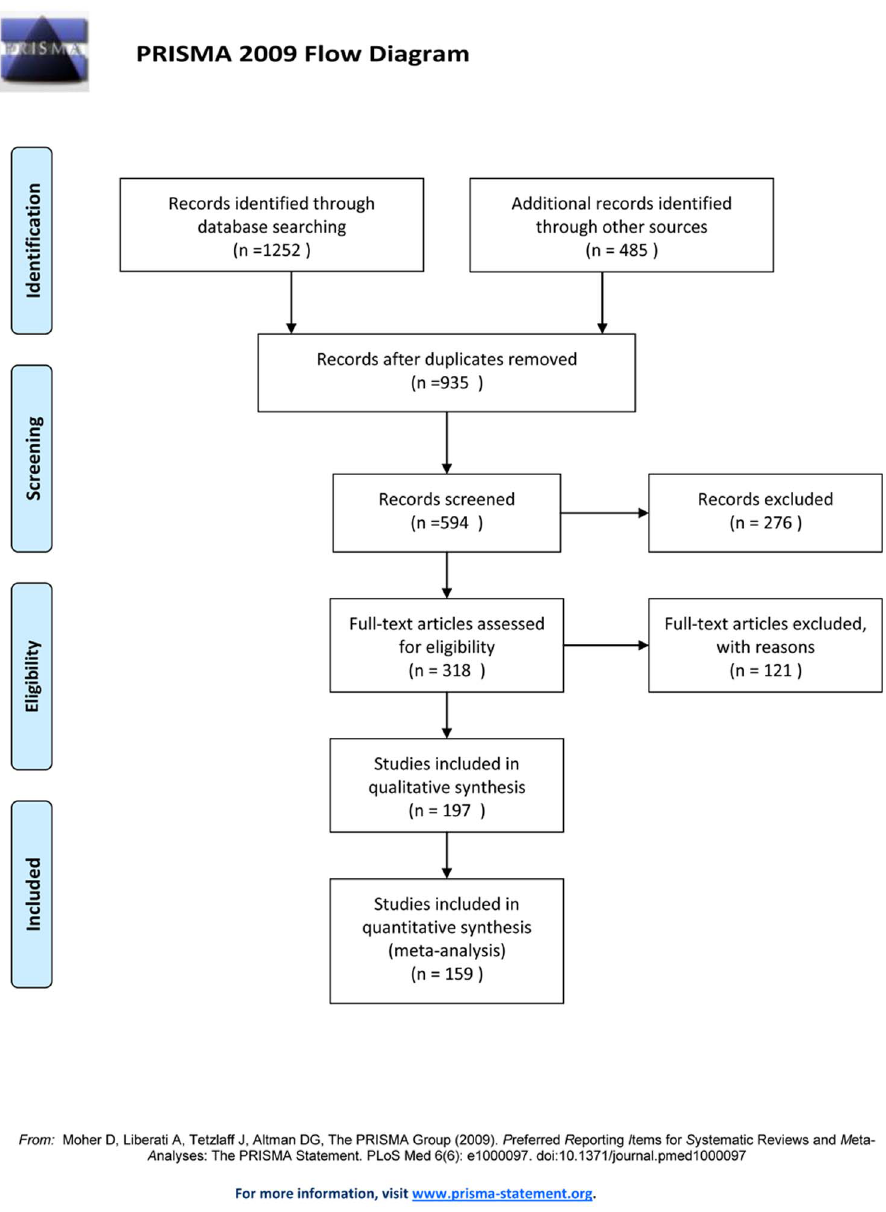
Figure 1. Procedure of articles analysis.